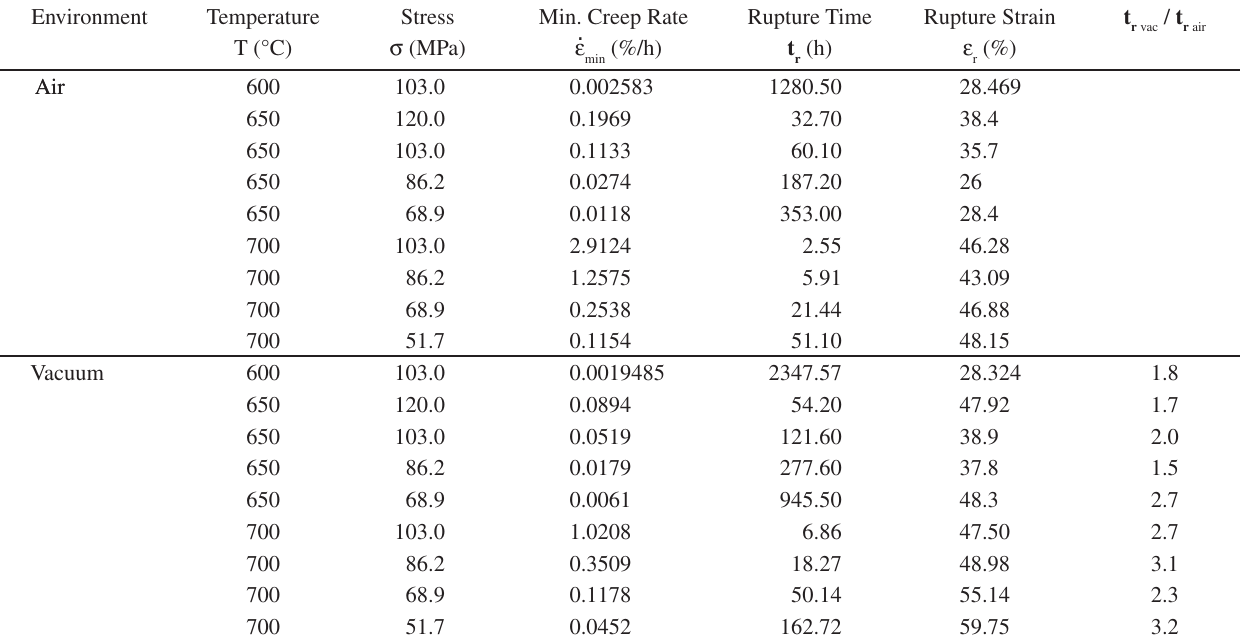
Figure 4. Typical creep curves of 2.25Cr-1Mo steel in air and in vacuum at different temperatures and applied stresses Table 1. 2.25Cr-1Mo creep data in air and vacuum.